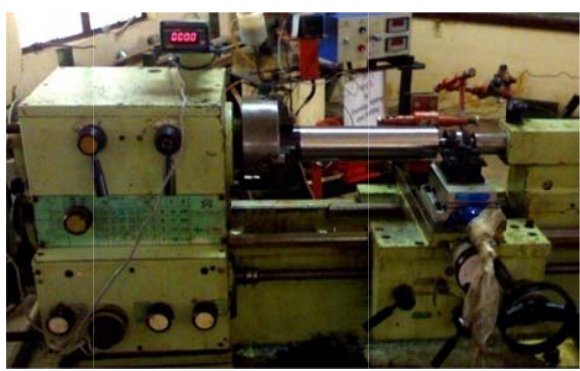
Figure 2. Experimental configuration setup.